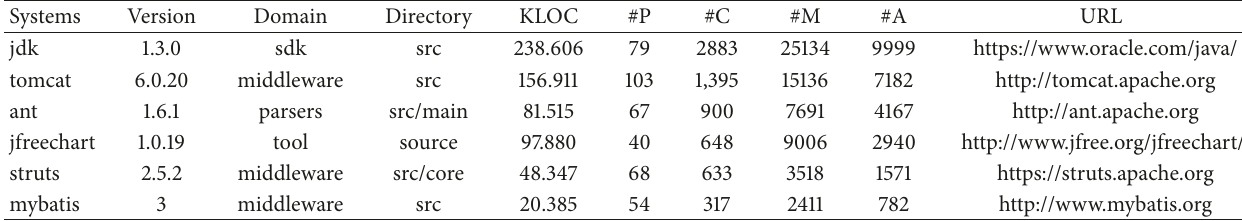
Table 2: Descriptions of the subject software